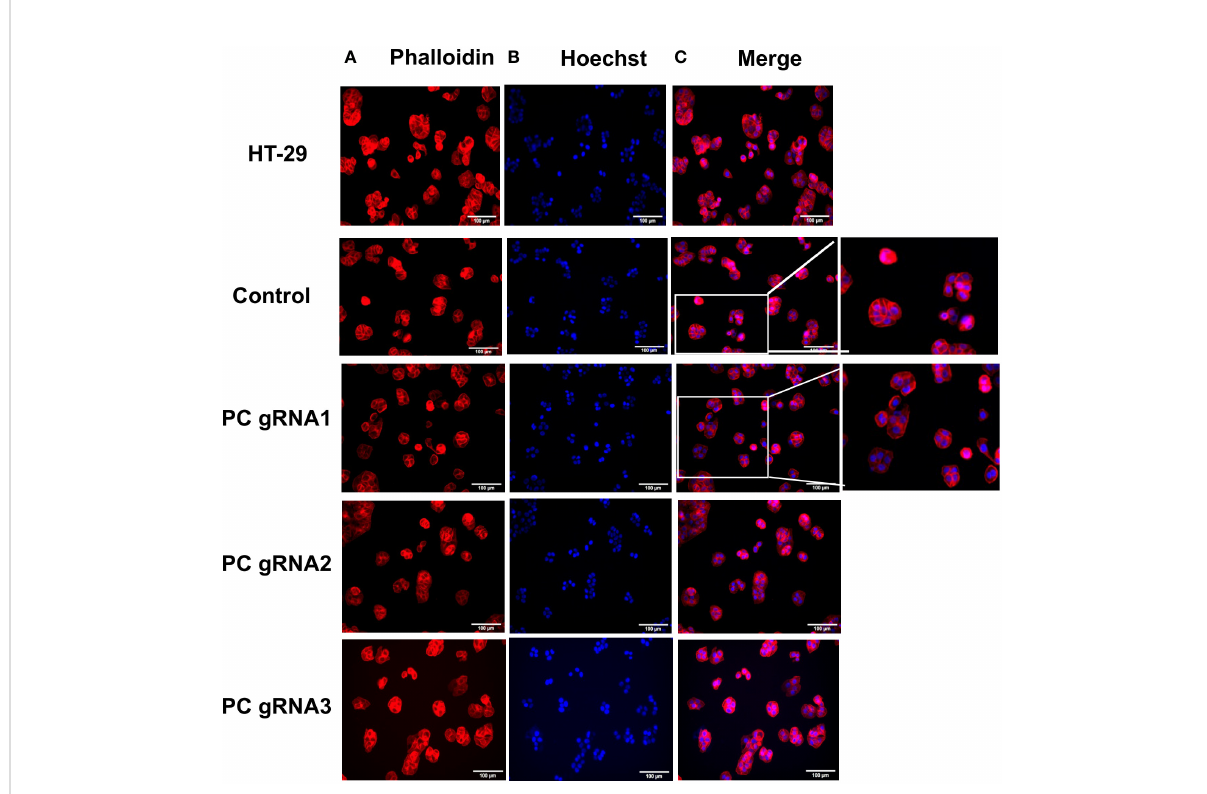
FIGURE 2 Morphology of PC KO HT-29 cell lines. Immuno fl uorescent images of parental HT-29, HT-29-empty vector (control) and three PC KO cells (gRNA1, gRNA2, and gRNA3) stained with phalloidin (A) and Hoechst 3342 (B) and overlay of phalloidin and Hoechst images (C)